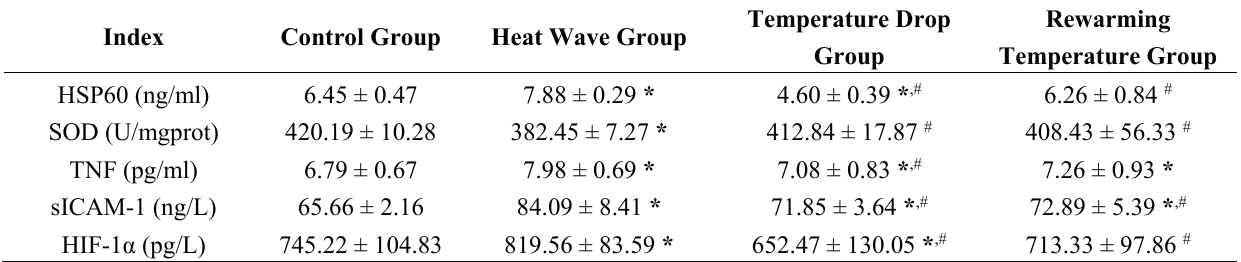
Table 2. Comparison of HSP60, SOD, TNF, sICAM-1, and HIF- α (mean ± sd., n =